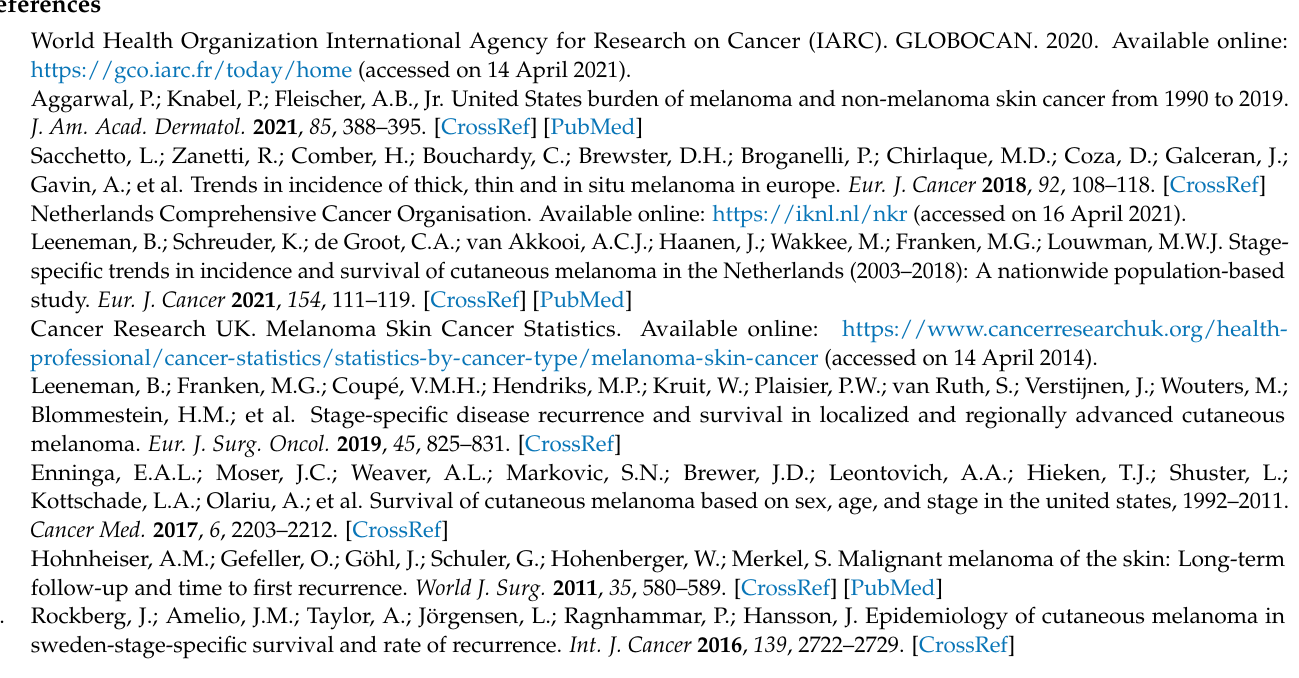
Table S5: The localisation of distant metastases in relation to patient and tumour characteristics in a univariate model with the lungs as the reference metastasized